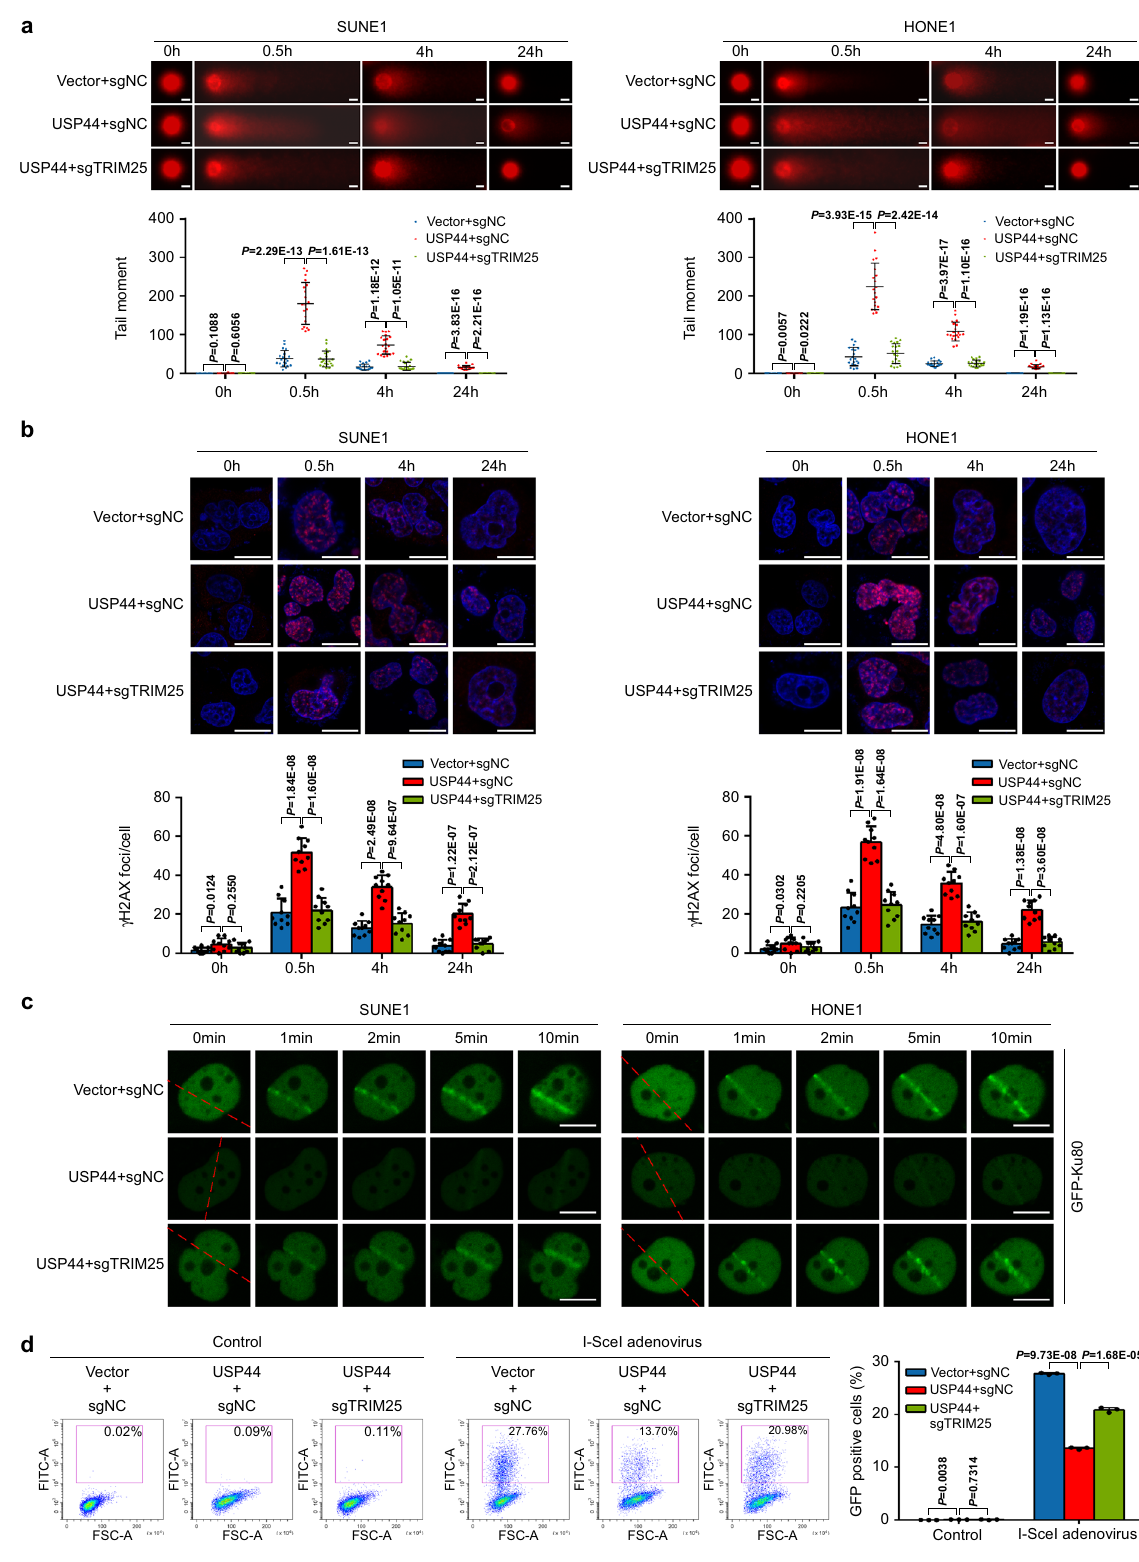
Bisul fi te pyrosequencing analysis . Fresh-frozen specimens and cell lines were treated with the AllPrep RNA/DNA Mini Kit (Qiagen) or EZ1 DNA Tissue Kit (Qiagen), respectively, to extract genomic DNA. Genomic DNA was modi fi ed by bisul fi te using the EpiTect Bisul fi te Kit (Qiagen). PyroMark Assay Design Software 2.0 (Qiagen) was used to design the USP44 bisul fi te pyrosequencing primer and PCR primer listed in Supplementary Table 3. The sequencing reaction and